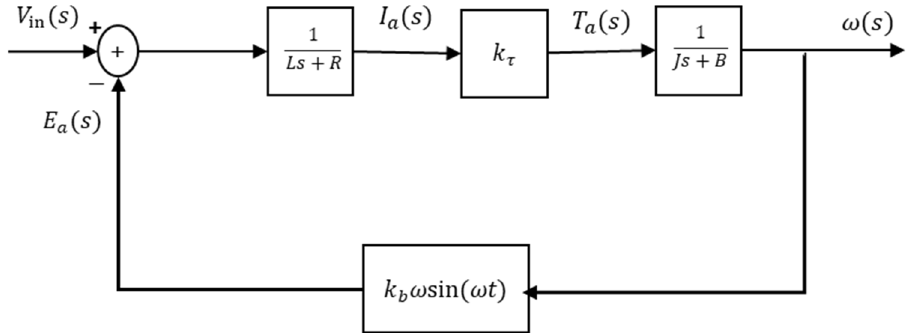
Figure 2. Block diagram of brushed dc motor with added vibration components.